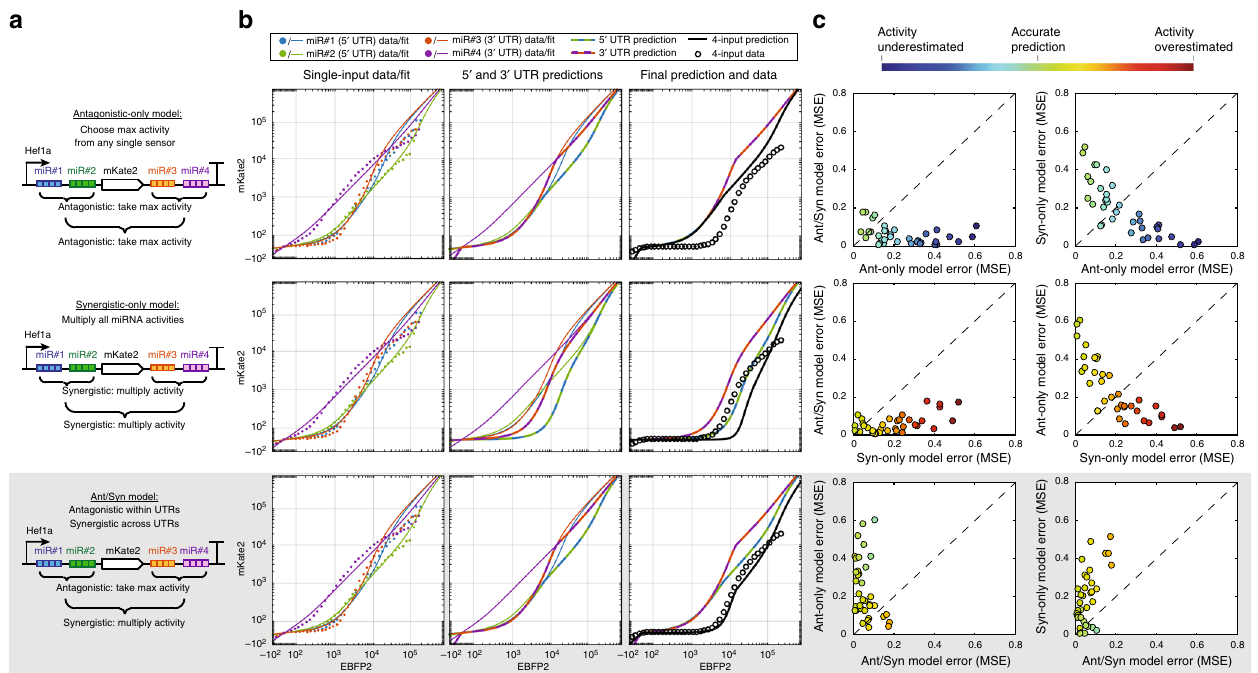
Fig. 5 Ant/Syn model provides accurate predictions of 4-input miRNA classi fi ers. a Diagrams for 4-input sensors with associated logic for combining miRNA activity annotated for the antagonistic-only model (top row), synergistic-only model (middle row), and Ant/Syn model (bottom row). Two sets of distinct miRNA target sites were placed in each 5 ′ and 3 ′ UTR. b Example 4-input predictions based on single-input data. Rows across panels depict analysis of the sensor con fi guration in a . Single-input miRNA sensor data and model fi ts are shown for each of the four miRNAs (left column). Predictions are made separately for the 5 ′ and 3 ′ UTRs (center column) by taking the maximum activity for any single sensor (antagonistic-only model and Ant/Syn model) or alternatively by multiplying fold changes (synergistic-only model) in each transfection marker bin. Final predictions are made (right column) by combining activities from 5 ′ and 3 ′ UTRs by multiplying fold changes for each UTR (synergistic-only model and Ant/Syn model) or by taking maximum activity (antagonistic-only model). For this example, miR#1 = miR-17-5p, miR#2 = miR-31-3p, miR#3 = miR-519a-3p, and miR#4 = miR-16-5p. All 36 miRNA target combinations tested with associated predictions and data can be found in Supplementary Figs. 12 – 15. c Comparison of error in antagonistic- only, synergistic-only, and Ant/Syn model predictions for 36 different classi fi ers. Errors calculated as mean squared error between prediction and obtained data are plotted for each of the three possible comparisons. Additionally, points are colored by the degree of miRNA activity underestimation or overestimation according to the model plotted along the x axis (i.e., top row colored by antagonistic-only model errors, middle row by synergistic-only model error, bottom row by Ant/Syn model errors), resulting in six total graphs. For all 36 tested combinations of miRNAs, errors from the Ant/Syn model were similar or better than those from the other two models, as shown by most points falling within upper-left triangle. In comparison, the antagonistic- only model tended to underestimate repression and the synergistic-only model tended to overestimate